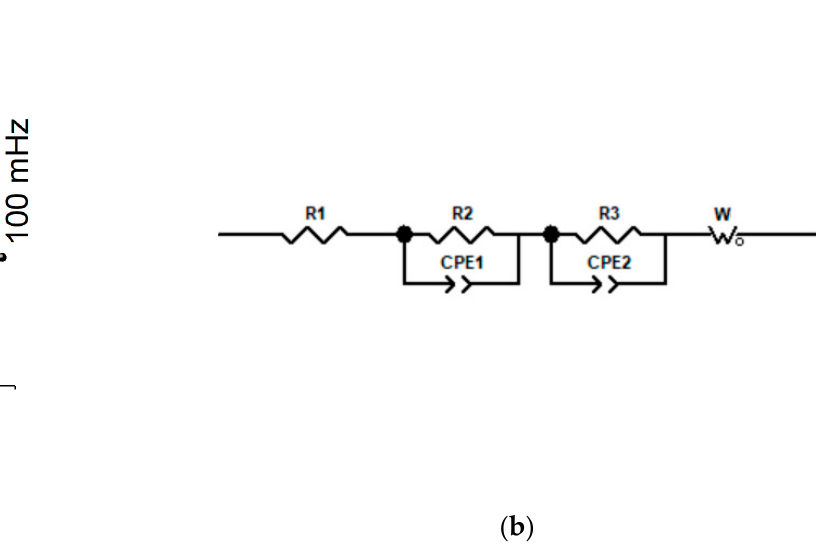
Figure 6. ( a ) Nyquist plots of CoGe 2 P 0.1 upon lithium (1) and sodium (2) insertion; ( b ) an equivalent circuit for simulating the impedance of CoGe 2 P 0.1.